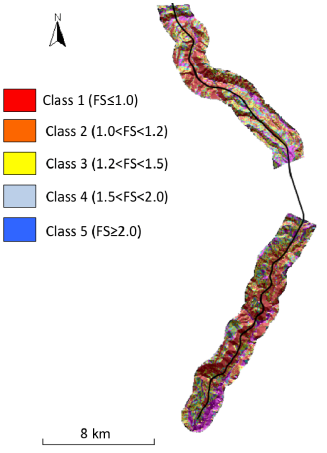
Figure 7. Landslide susceptibility maps using model M3 and the parameter set obtained by optimizing